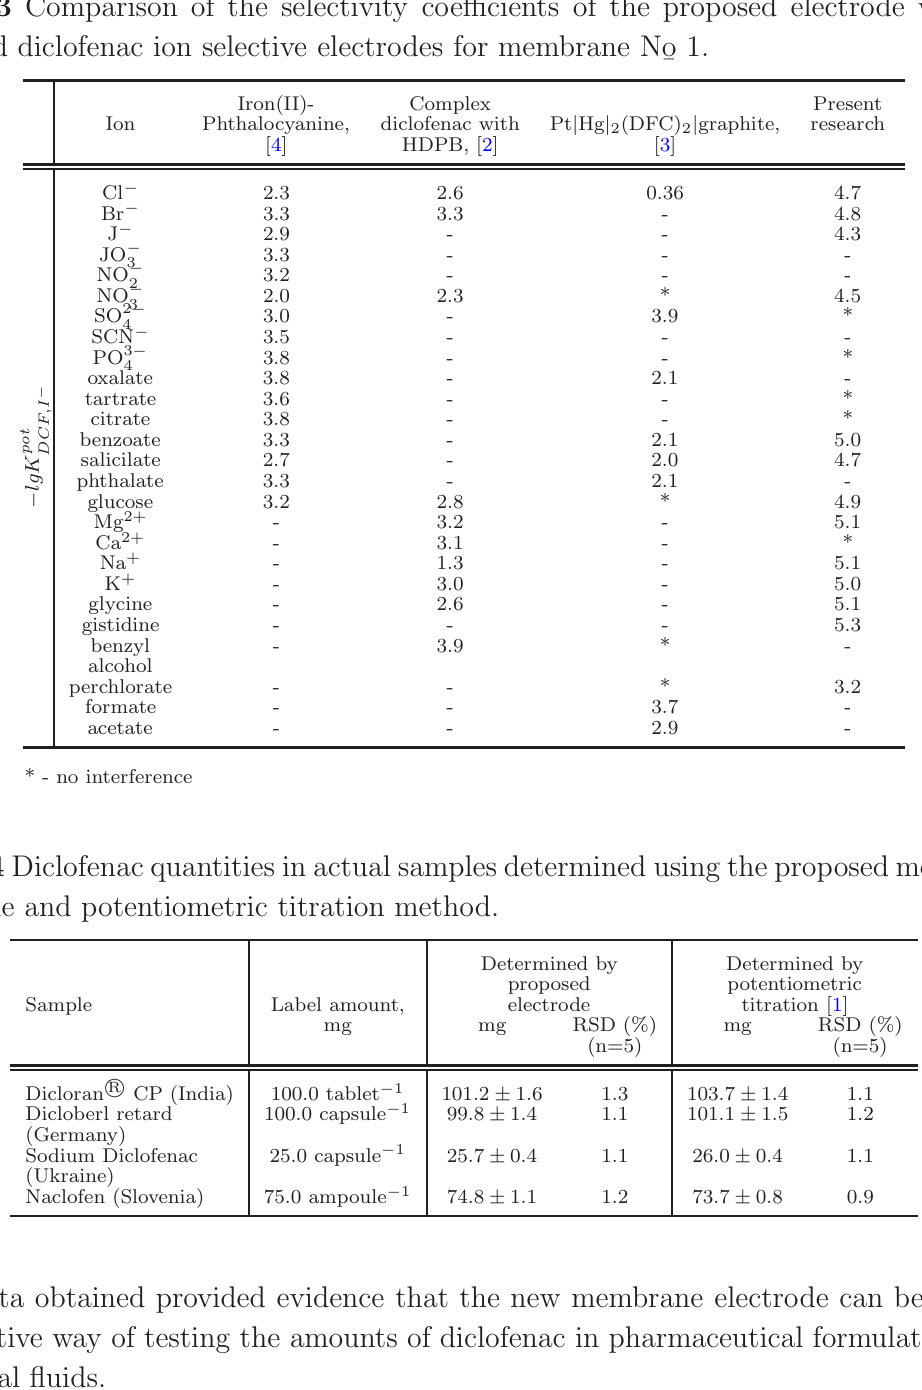
Table 3 Comparison of the selectivity coefficients of the proposed electrode with the reported diclofenac ion selective electrodes for membrane No